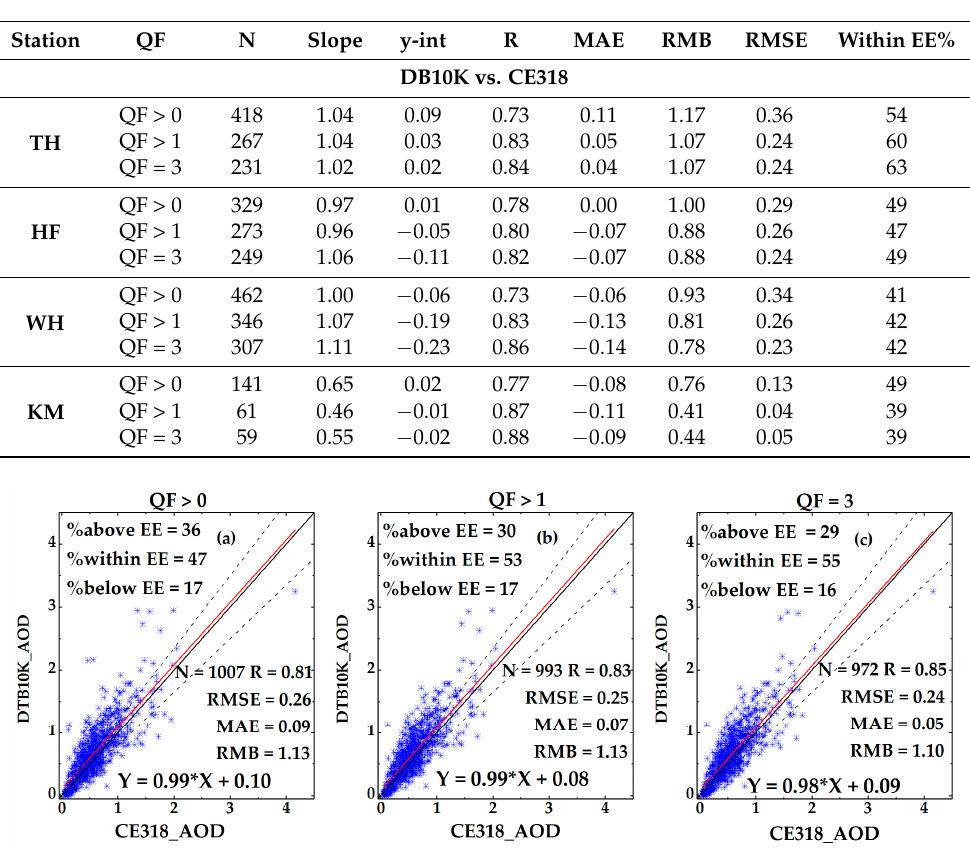
Figure 5. As in Figure 2, but comparison of the DTB10K AOD products. The DT10K AOD retrievals with QF > 0, QF > 1 and QF = 3 are presented in ( a – c ), respectively.